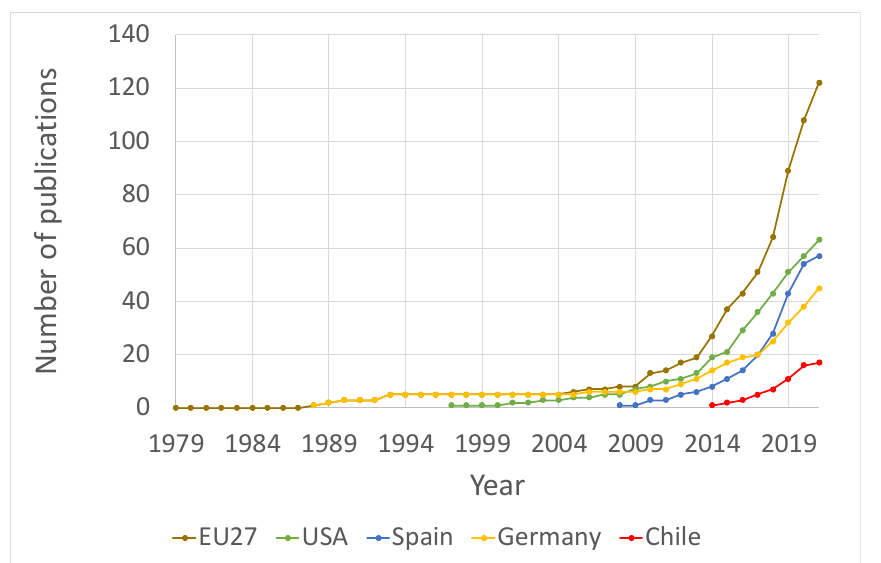
Figure 6. Top countries publishing on the topic including EU27. Table 1. Operational capacity of CSP installed in different countries/territories